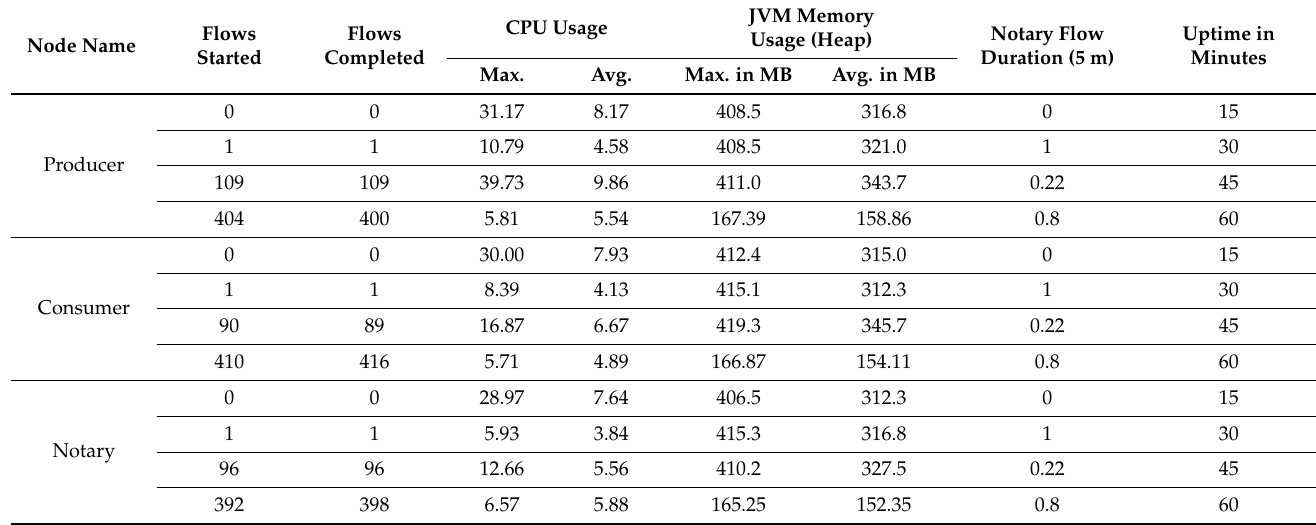
Table 3. Summary of the performances measured for our proposed Corda network.